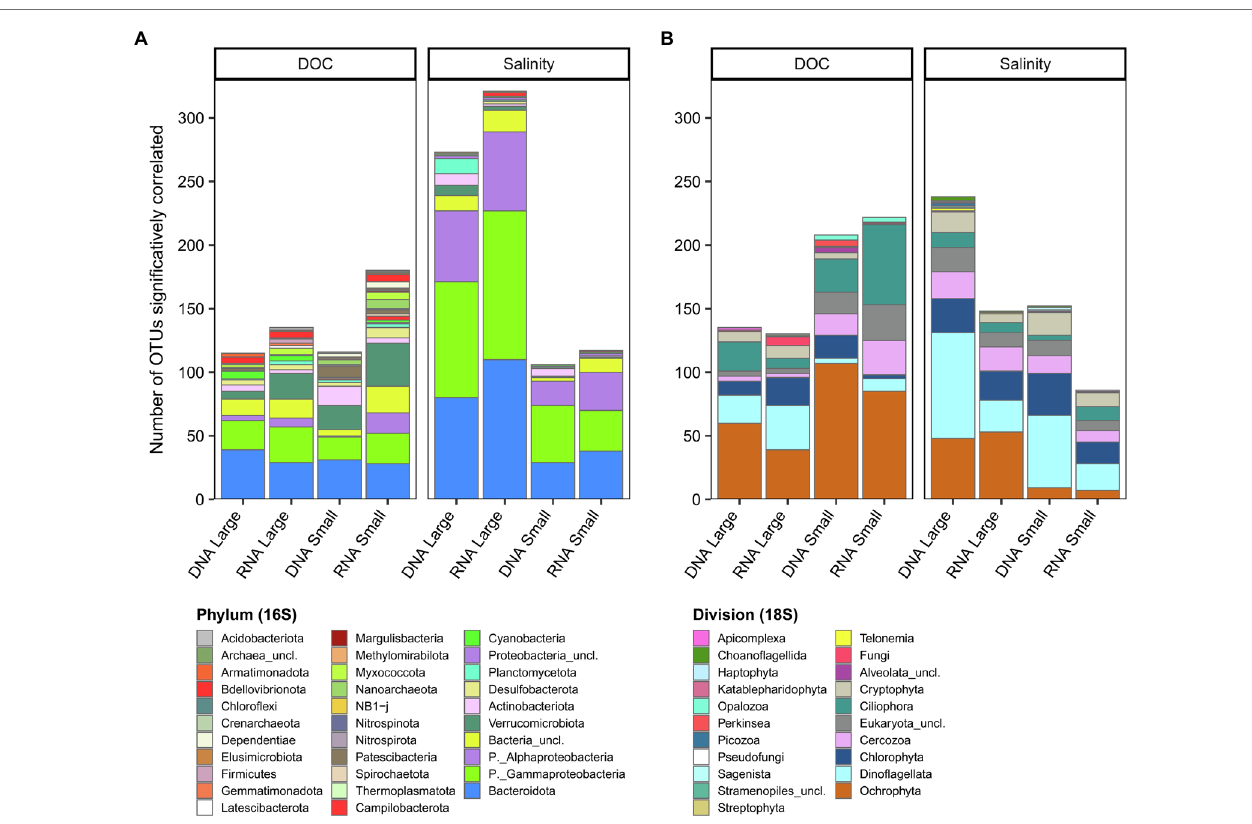
FIGURE 8 | Number of OTUs significantly correlated to DOC or salinity for each rDNA or rRNA fraction for bacterioplankton (A) and microbial eukaryotes (B) . The OTUs are grouped at the phylum level for bacterioplankton (A) and division level for microbial eukaryotes (B)